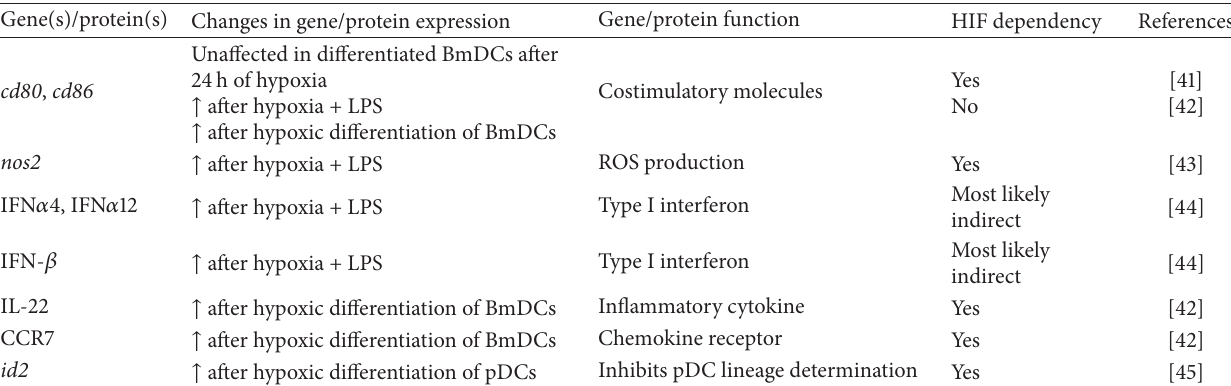
Table 2: Gene/protein expression changes induced by hypoxia in murine